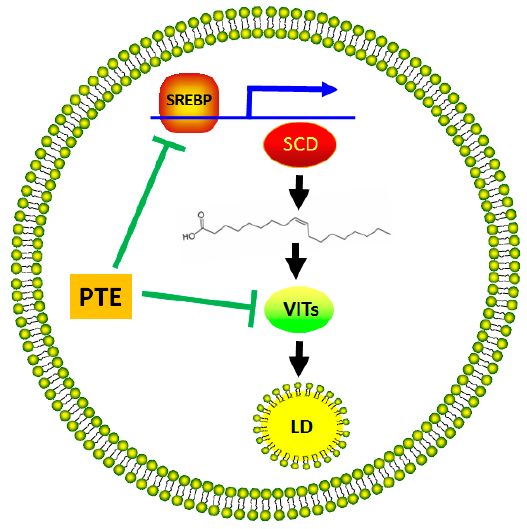
Figure 4. A proposed model to explain the underlying mechanisms of the Pu-erh tea anti-obesity effect. Pu-erh tea downregulates the expression of transcription factor SREBP (sterol regulatory element binding protein), which then reduces the transcriptional expression of SCD (stearoyl-CoA desaturase) that converts saturated fatty acids to monounsaturated fatty acids, leading to a reduction of de novo synthesis of fatty acids [22]. Meanwhile, Pu-erh tea also inhibits the expression of vits to reduce lipid transport to lipid droplets (LD) for storage, thereby leading to fat reduction. Please explain the yellow ball and wave line. The outside yellow ball indicates the double phophoslipid memebranes of cell, and the inside small yellow ball indicates intracellular lipid droplet wrapped by monolayer phophoslipid. The wave line indicates a monounsaturated fatty acid.